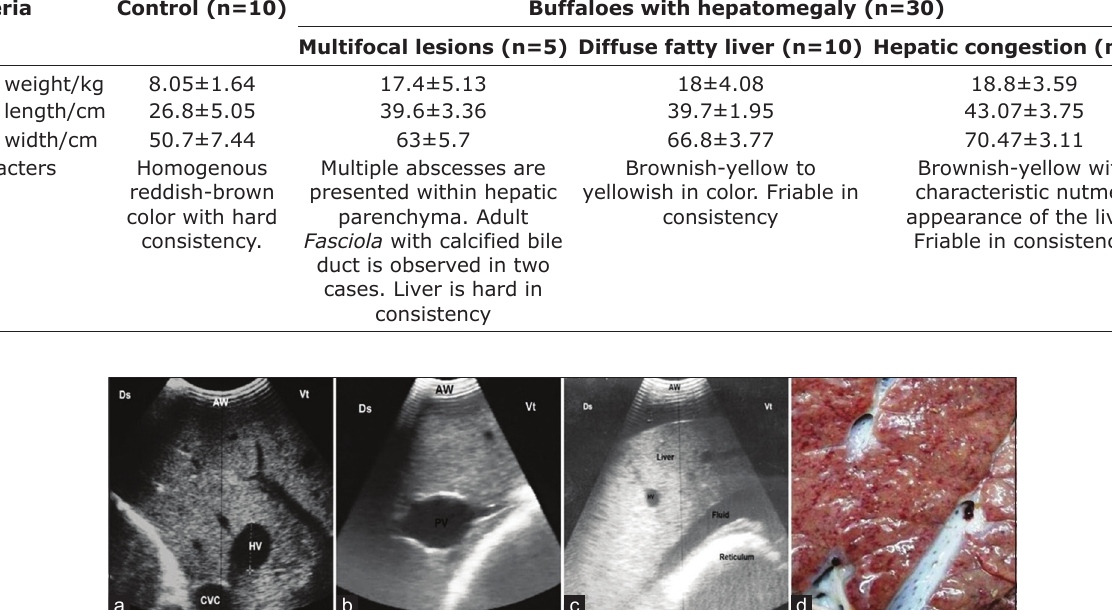
Table-3: Necropsy findings of 30 buffaloes with hepatomegaly in comparison with 10 controls. Criteria